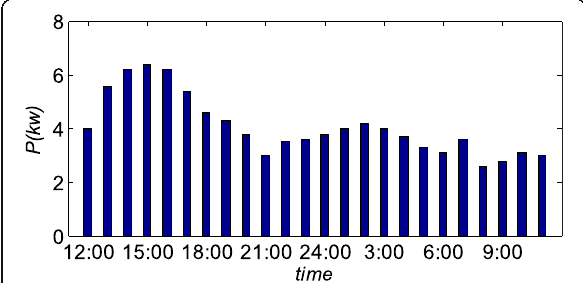
Fig. 5 The typical curve of DG